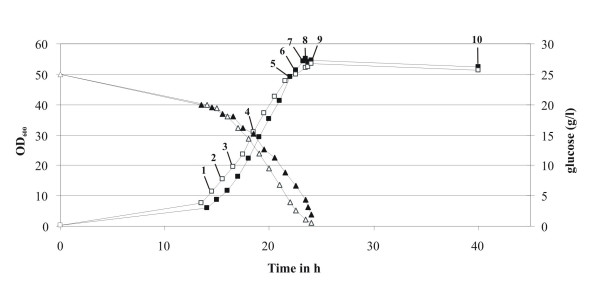
Growth and sugar consumption during batch-fermentation of C. glutamicum RES167 (black squares) and the sigB mutant C. glutamicum CL1 (open squares) in minimal medium MM1 at 30°C and pH 7. Growth was monitored by measuring the optical density (o.D.) at a wavelength of 600 nm. Black triangles symbolize the remaining glucose in cultures of C. glutamicum RES167, open triangles show the glucose concentration in cultures of the sigB mutant C. glutamicum CL1. The numbers correspond to different sampling points of C. glutamicum RES167 and C. glutamicum CL1 cells for further analyses.